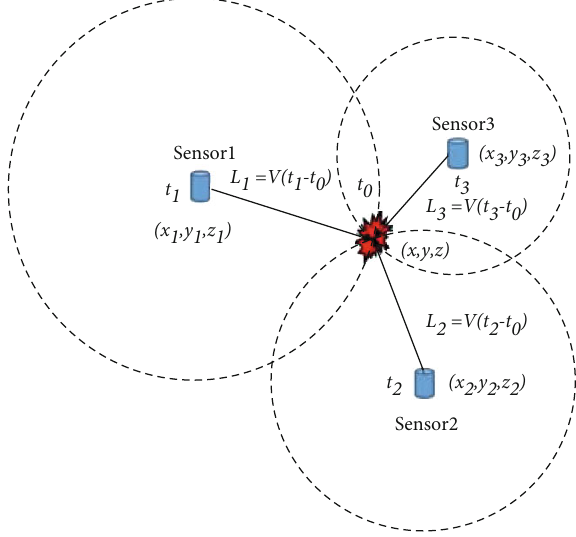
Figure 4: Schematic diagram of the source location